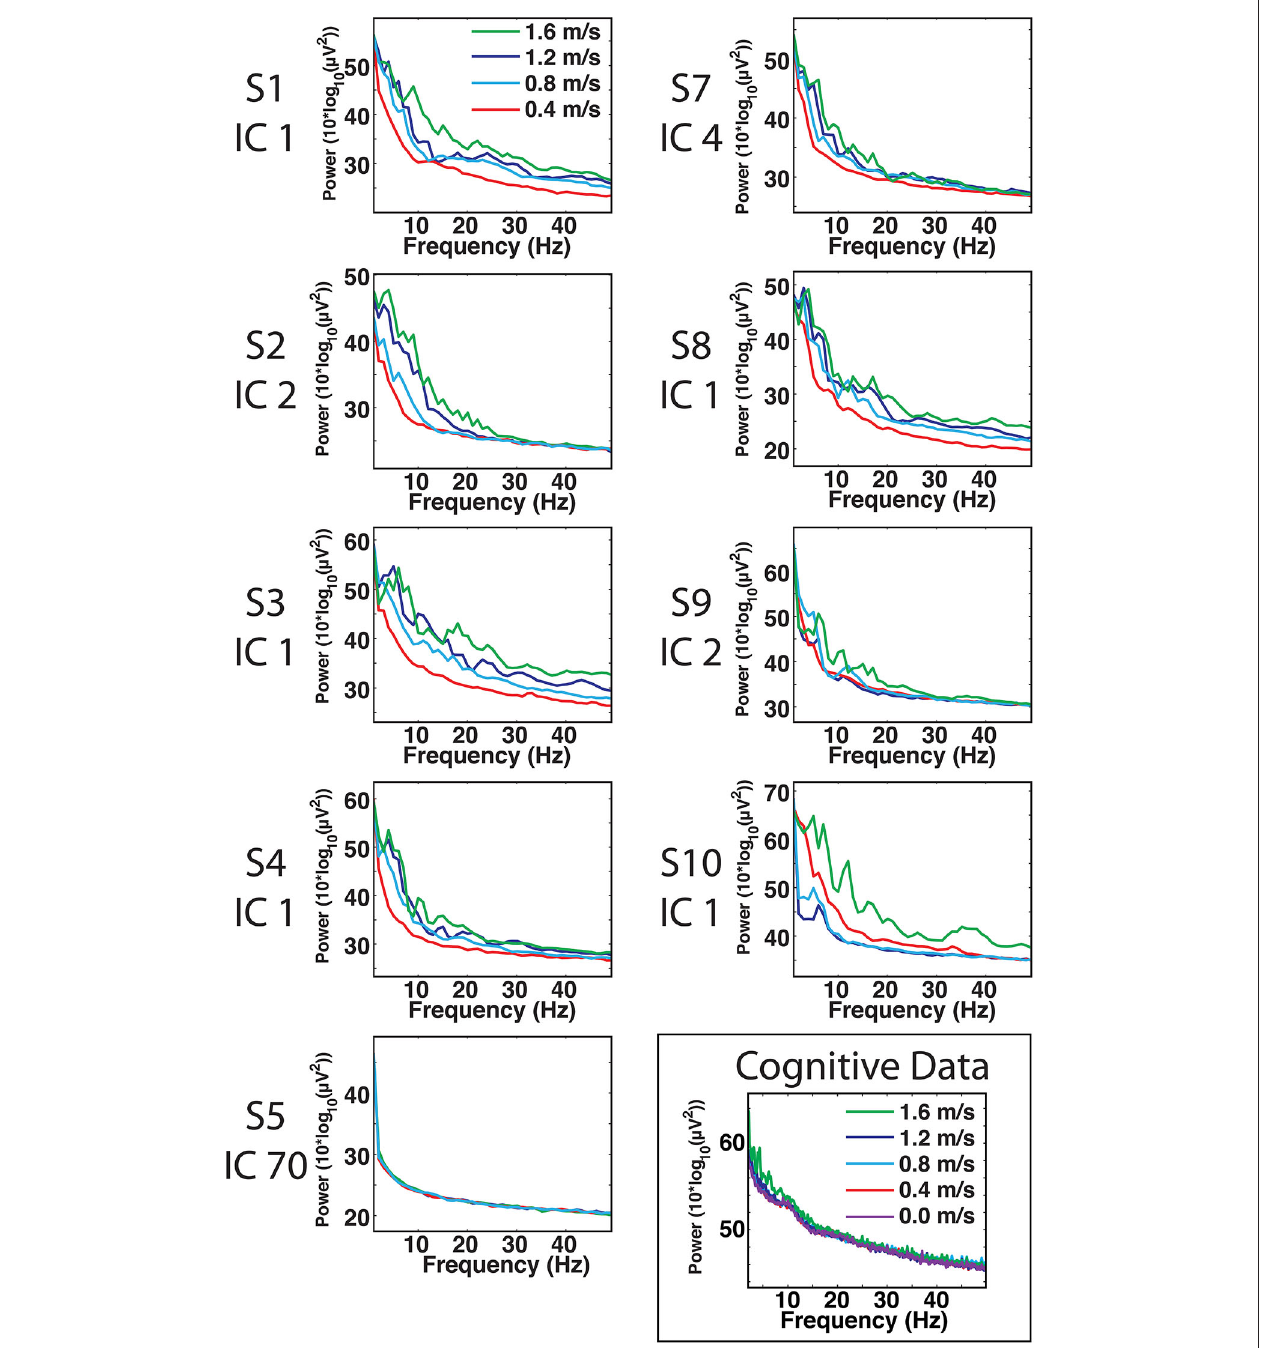
FIGURE 4 | Cortical component spectra. Power spectra for the artifact data show large spectral peaks at the stride frequency and resonant frequencies thereof, particularly at speeds of 1.2 and 1.6 m/s. The peaks of the movement artifact data are large compared to those found in neural data, but neural data at 1.6 m/s does show some signs of movement